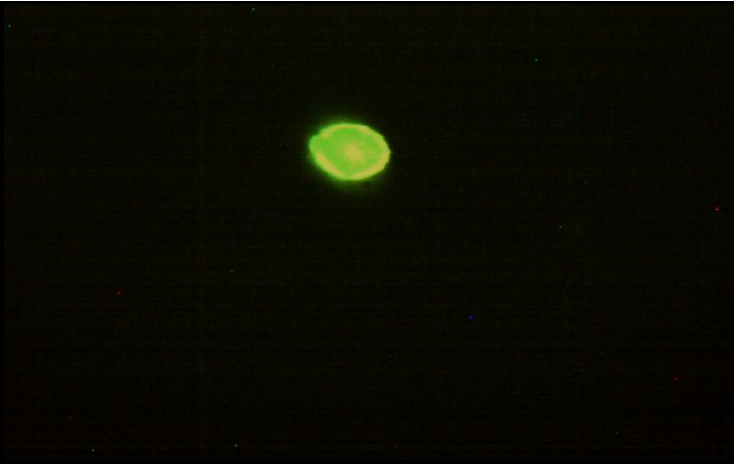
Figure 13: Result of IFAT showing positive result. 8- ELISA test for BPIV- 3 antibodies detection : Results of ELISA test showed positive detection of BPIV- 3 antibodies in serum samples of two calves suffered from respiratory tract infection as these calves were the same animals from which virus was isolated from their nasal swabs. These calves showed an optical density of 1.543 and 0.860 respectively in